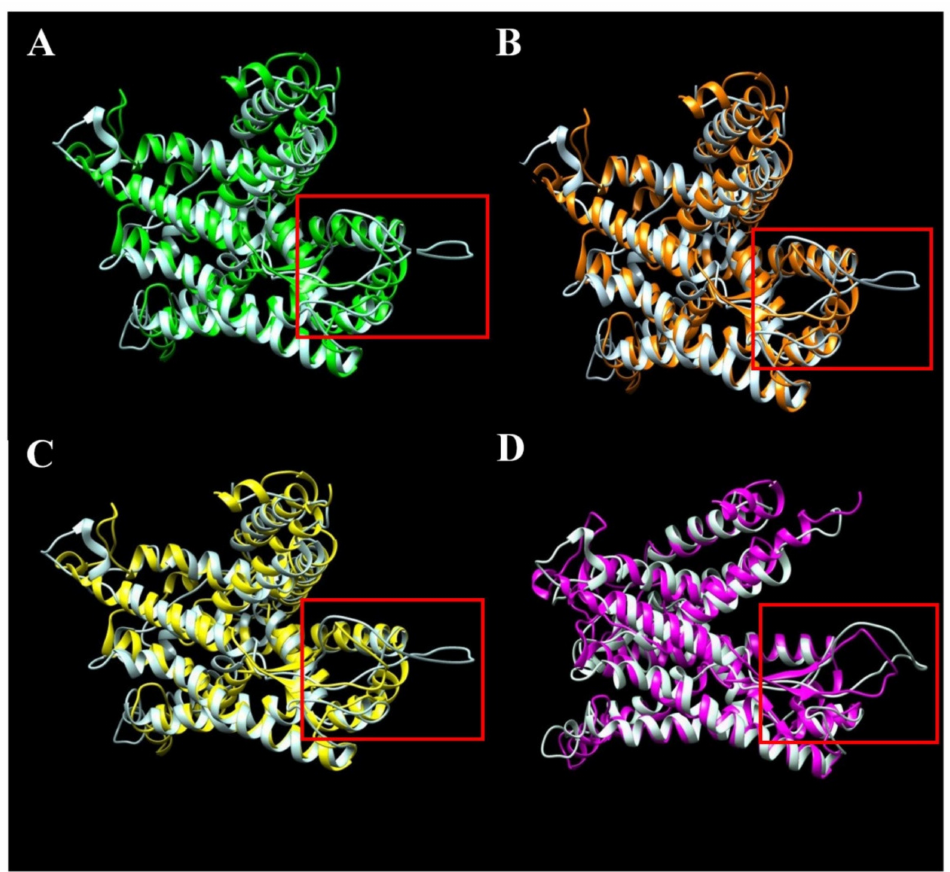
Figure 7. Structural comparison through overlap of semi-conservative variant SecY52 colored in white with conservative variants SecY1 ( A ), SecY6 ( B ), SecY9 ( C ), and SecY33 ( D ). Three-dimensional structures were modelled based on the sequence alignment with Bacillus subtilis SecY (6itc.1) (Supple- mentary Figure S2). The hypothetical disordered region is indicated in the red colored